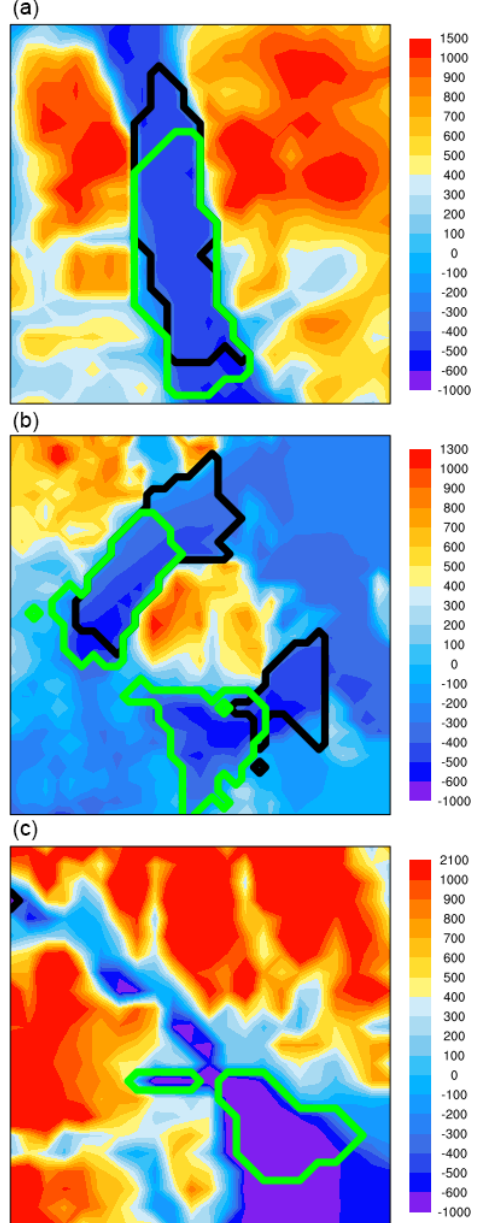
Figure 17. Close-ups of three regions with floating ice at the end of a 50kyr Greenland spin-up with ice shelves: Petermann Glacier (a) , 79 North Glacier and Zachariae Isstrom (b) , and Kangerlussuaq Glacier (c) . These regions are enclosed by boxes in Fig. 15. The shaded color shows the bed topography (m). Black and green con- tours enclose regions that are floating at the start and end of the sim- ulation, respectively. Calving fronts are located at the north, north- east, and southeast shelf boundaries, respectively, from top to bot- tom; grounding lines are located at the south, southwest, and north- west shelf boundaries,